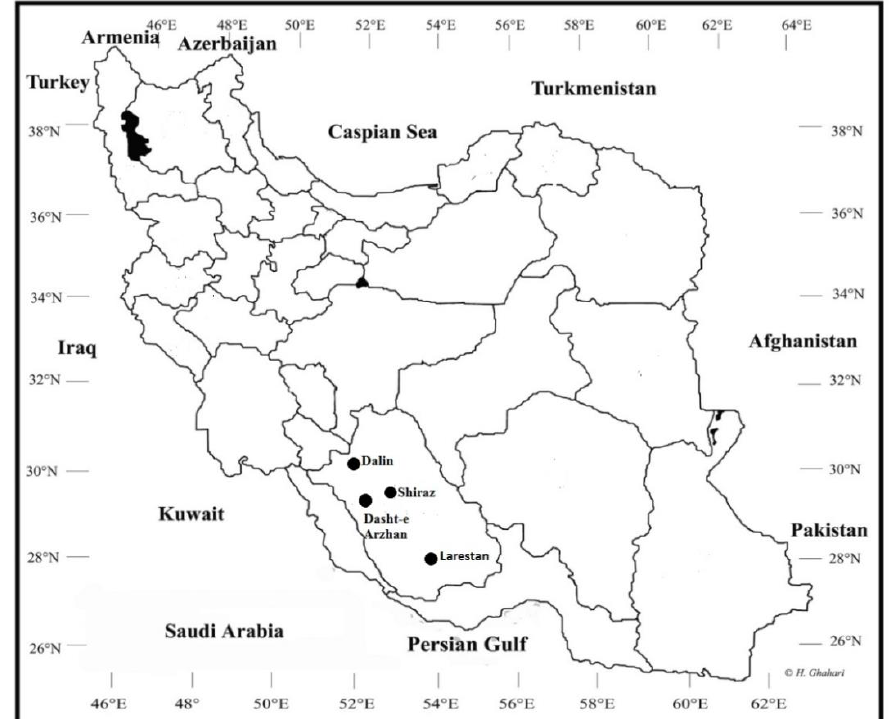
Fig. 1. Map of Iran and location of the sampling localities in Iran.